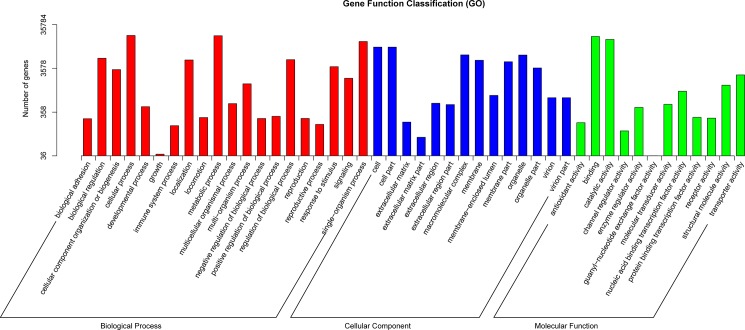
Functional annotation of unigenes based on Gene Ontology (GO) classification.